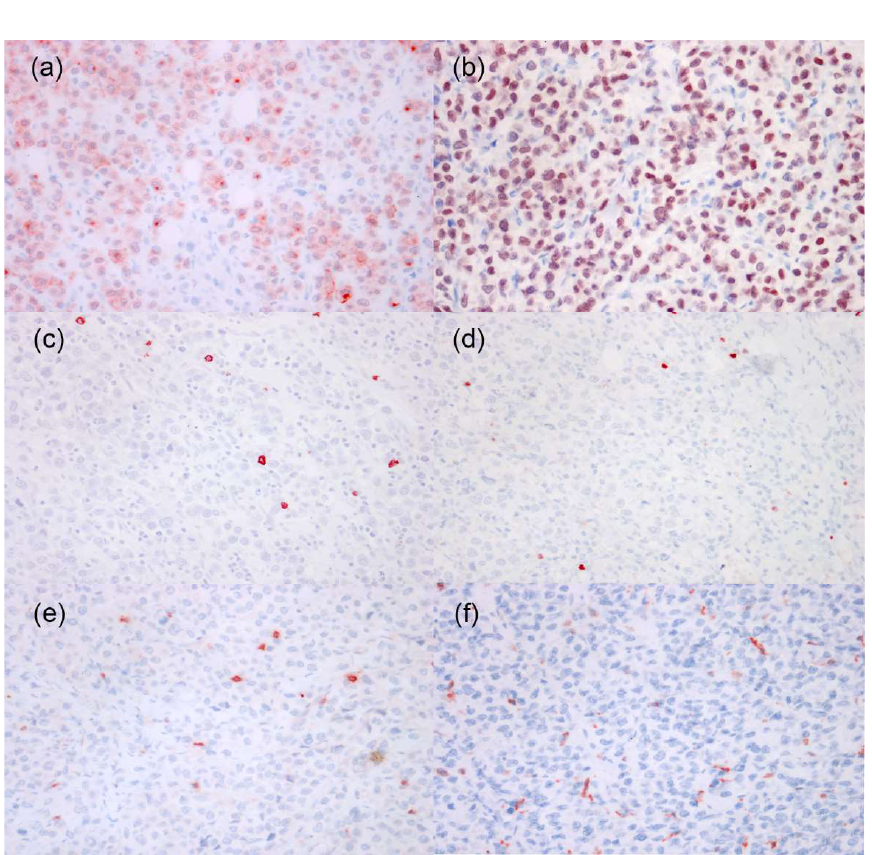
Figure 4. Immunohistochemistry of tumor cells in a case of in a case of canine cutaneous non epitheliotropic B-cell lymphoma (CNEBL) vs. multiple cutaneous plasmacytosis (CP). ( a ) The neoplastic cells have moderate to strong cytoplasmic expression of CD79a. CD79a (40×). ( b ) The neoplastic cells have strong nuclear expression of MUM1. IHC for MUM1 (40×). ( c ) The neoplastic cells are negative for CD20. Scattered CD20+ reactive lymphocytes are noted among neoplastic cells. CD20 (40×). ( d ) The neoplastic cells are negative for PAX5. Scattered PAX5+ reactive lymphocytes are noted among neoplastic cells. PAX5 (40×). ( e ) The neoplastic cells are negative for CD3. Scattered CD3+ reactive lymphocytes are noted among neoplastic cells. CD3 (40×). ( f ) The neoplastic cells are negative for IBA1. Scattered IBA1+ reactive histiocytes are noted among neoplastic cells. IBA1 (40×) .